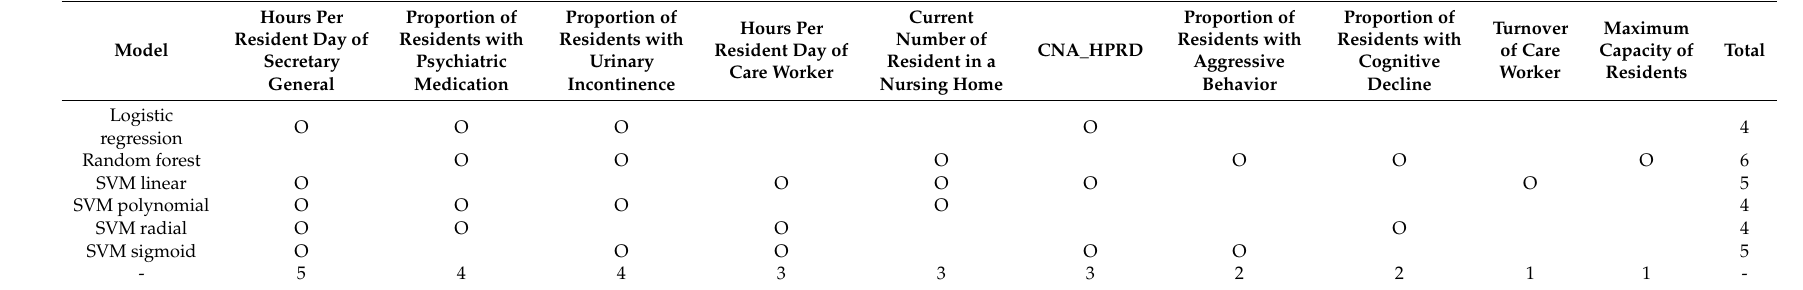
Table 1. Predicting Variables of Six